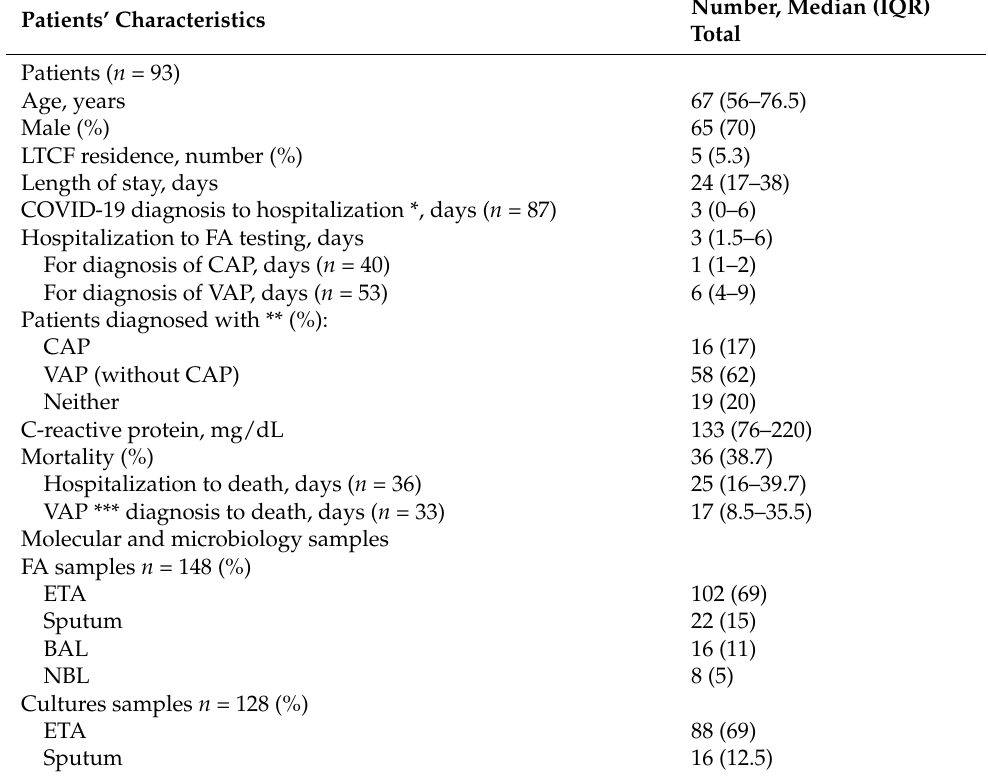
Table 1. Ventilated COVID-19 patients and microbiology samples